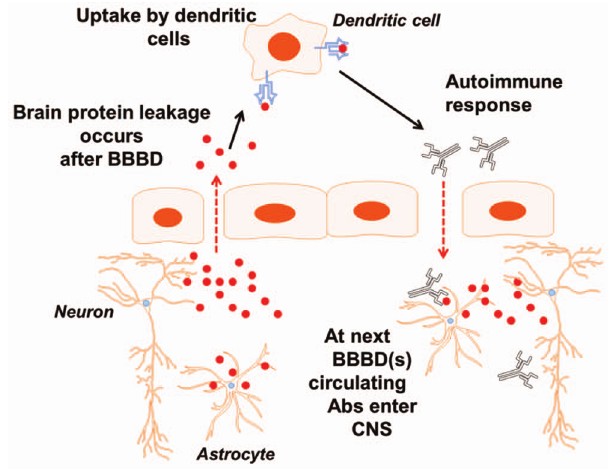
Figure 7. Schematic representation of the events that follow BBBD. See text for